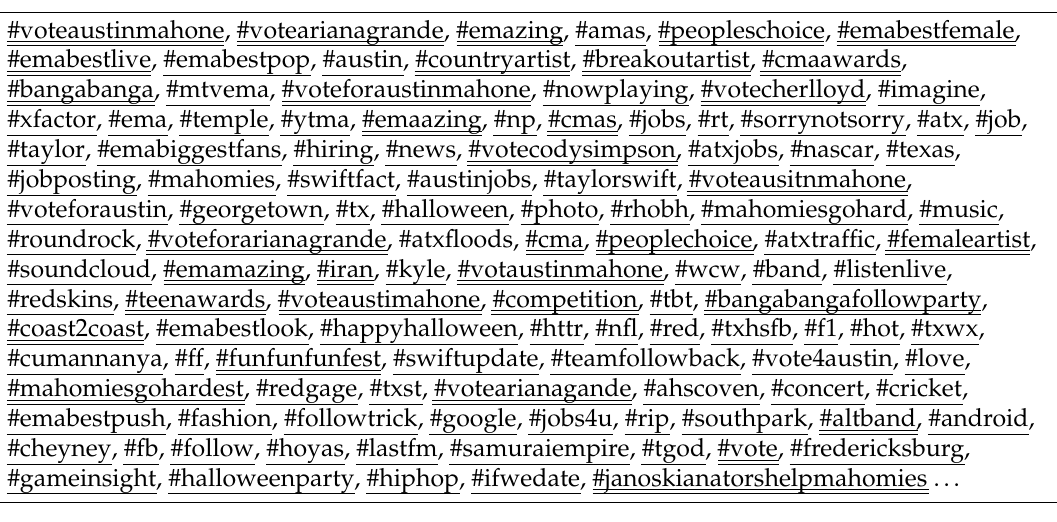
Figure 6. List of hashtags used in messages from the impact area of flood in Texas, USA